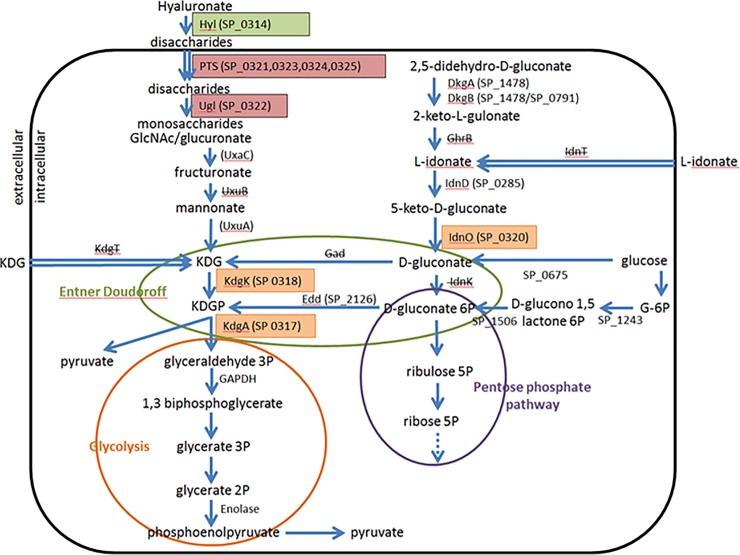
Proposed metabolic pathways of hyaluronate and L-idonate in S. pneumoniae.Solid arrows indicate the directions of metabolic processes. Dotted arrow shown in the pentose phosphate pathway (purple circle) indicates further reactions down the pathway. Double arrows indicate transports of molecules. Proteins whose names have been striked through indicate that homologs could not be identified among S. pneumonia strains. To correspond to Fig 1, candidate gene products in our study (SP 0317, SP 0318, SP 0320), the PTS transport system (SP 0321, SP 0323, SP 0324, SP 0325) along with glucuronyl hydrolase (SP 0322), and the hyaluronate lyase (Hyl) protein have been highlighted in orange, pink, and green, respectively. We postulate that SP 0675 functions as a glucose dehydrogenase, catalyzing the conversion of D-glucose to D-gluconate. In S. pneumoniae, KDG can be derived from two sources: mannonate and D-gluconate, via catabolism of hyaluronate (a glycosaminoglycan) and L-idonate, respectively. Catabolism of hyaluronate is initiated by a hyaluronate lyase (Hyl, encoded by SP 0314, located downstream to the kdg region). Hyl cleaves hyaluronate into disaccharides [55], which enter bacterial cell via a PTS transport system (encoded by SP 0321, SP 0323, SP 0324, SP 0325, upstream to the kdg region) [55, 67]. Once inside the cell, the disaccharides are further broken down into monosaccharides (D-glucuronate and N-acetyl-D-glucosamine) through glucuronyl hydrolase (Ugl), encoded by SP 0322 [55, 68]. It is likely that the monosaccharide D-glucuronate is metabolized to KDG in S. pneumoniae via the enzymatic actions carried out by glucuronate isomerase (UxaC), fructuronate reductase (UxuB) and mannonate dehydratase (UxuA) as described in E. coli [65, 69]. Although the homolog of E. coli’s UxuB, which catalyzes the conversion of fructuronate to mannonate, could not be identified in S. pneumoniae (with mannitol-1-phosphate 5-dehydrogenase [SP 0397] being the closest homolog, sharing 25% amino acid identity), it is possible that an uncharacterized enzyme or an enzyme with multiple functions could carry out this process. Interestingly, the homologs of UxaC and UxuA of E. coli (which respectively catalyze the conversions of glucuronate to fructuronate and mannonate to KDG) were only identified in the single S. pneumoniae strain, 70585 (their names are respectively SP70585_ 2238 and SP70585_ 2237). In addition to the degradation of hyaluronate, which yields mannonate as a precursor molecule of KDG, metabolism of L-idonate and its subsequent conversion to D-gluconate is an alternative source of KDG in S. pneumoniae. Metabolism of L-idonate to D-gluconate occurs via two enzymatic processes: 1) the conversion of L-idonate to 5KG, carried out by L-idonate 5 dehydrogenase (IdnD) (encoded by SP 0285); and 2) conversion of 5KG to D-gluconate by IdnO (encoded by one of the candidate genes in our study: SP 0320) [41]. Although it has been shown in other organisms that KDG could be derived from other sources, such as the hexuronate galacturonate and plant pectin [70–72], these are less likely to be relevant in S. pneumoniae as none of the homologs required for the metabolism of galacturonate and pectin could be identified in S. pneumoniae. Metabolism of KDG to G3P via the Entner-Doudoroff pathway (shown in green) requires the enzymatic actions of KdgK and KdgA, which are respectively encoded by two of the genes in our study: SP 0318 and SP 0317. KdgK and KdgA convert KDG to KDGP and KDGP to G3P and pyruvate, respectively. G3P produced could subsequently enter the latter steps of glycolysis (circled in orange) to yield further pyruvate and phosphoenolpyruvate. Abbreviations in the diagram: Hyl, hyaluronidase; PTS, phosphate transport system; Ugl, glucuronyl hydrolase; UxaC, glucuronate isomerase; UxuB, fructuronate reductase; UxuA, mannonate dehydratase; KDG, 2-keto-3-deoxygluconate; KDGP, 2-keto-3-deoxygluconate 6-phosphate; GAPDH, glyceraldehyde 3-phosphate dehydrogenase; IdnD, L-idonate 5 dehydrogenase; IdnO, 5-keto-D-gluconate-5-reductase; IdnK, D-gluconate kinase; Gad, gluconate dehydratase; Edd, phosphogluconate dehydratase; G-6P, glucose 6-phosphate.